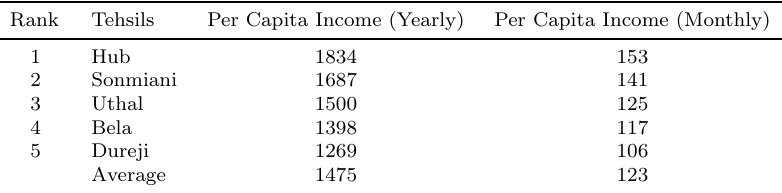
Table 5: Per Capita